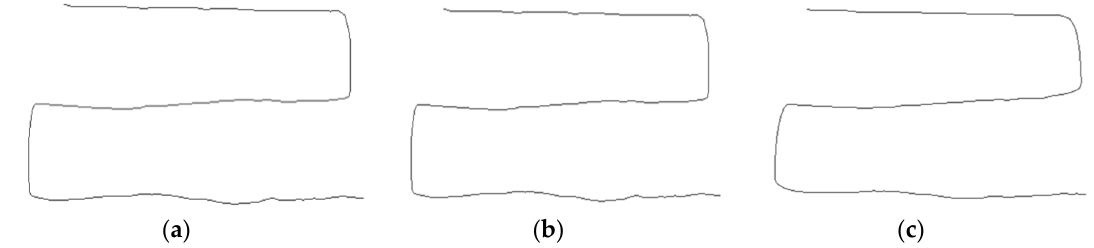
Figure 19. Shape distortion according to T f : ( a ) T f = 30; ( b ) T f = 100; ( c ) T f = 200.